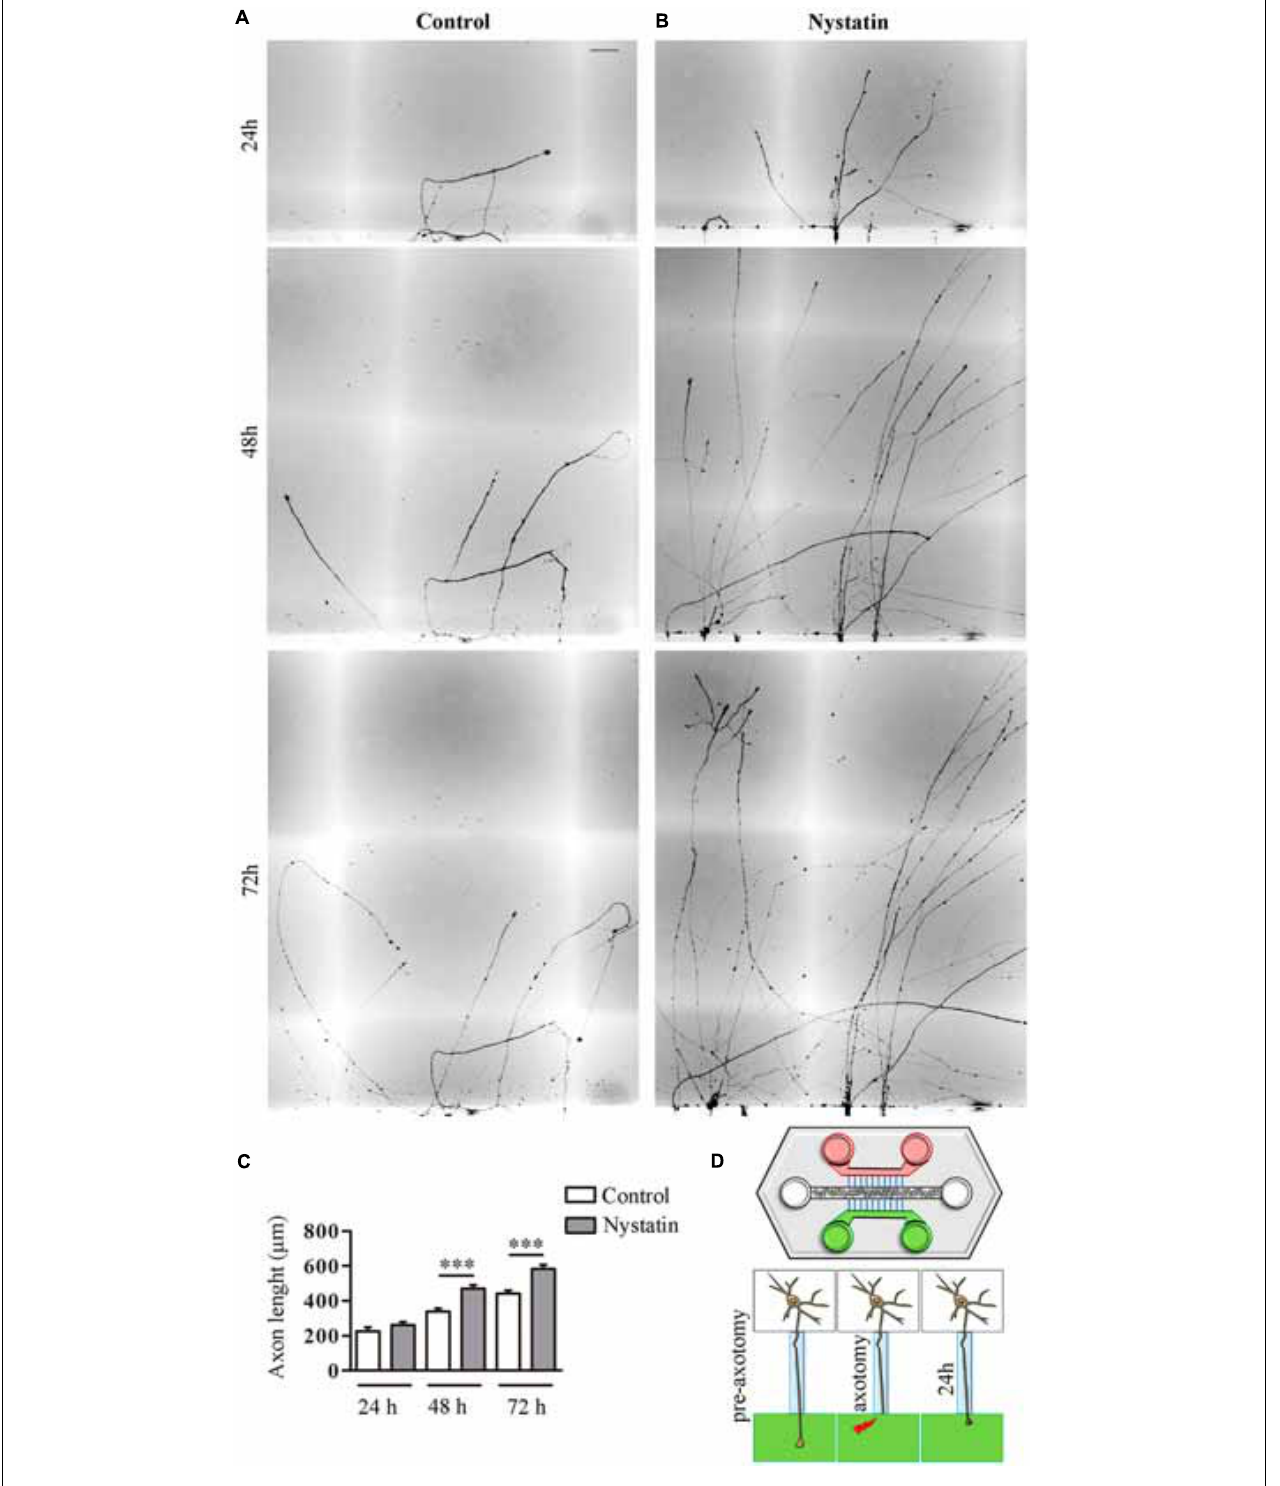
FIGURE 5 | Nystatin improves axon regeneration after axotomy in vitro . Examples of hippocampal axon regrowth at 24, 48, and 72 h after axotomy in control condition (A) and in response to treatment with 2.5 µ g/ml Nystatin (B) . Axon lengths were measured in each condition. Data represent means ± SEM (C) . Schematic diagram of a microfluidic chamber (D) . Cell bodies are in the central channel (white), axon growth through microfluidic channels (blue) to both sides (green and red). After axotomy, control medium was applied on one side (red) and Nystatin on the other (green). N = 3 chambers ( t -Test in each time point, ∗∗∗ p < 0.0001). Scale bar 50 µ